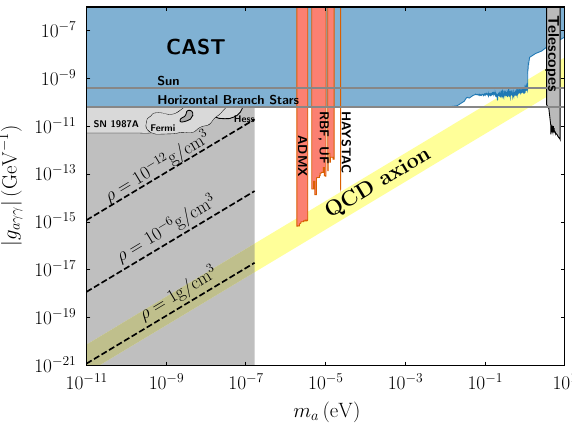
Sun Horizontal Branch Stars